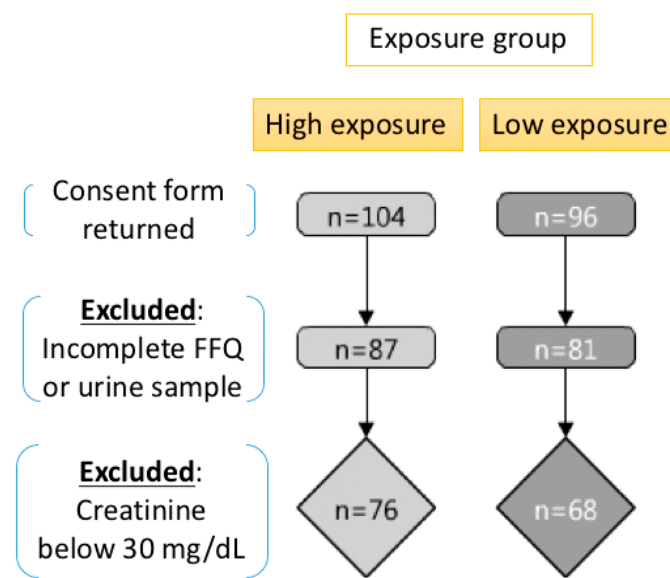
Figure 1. The study design and flow chart.